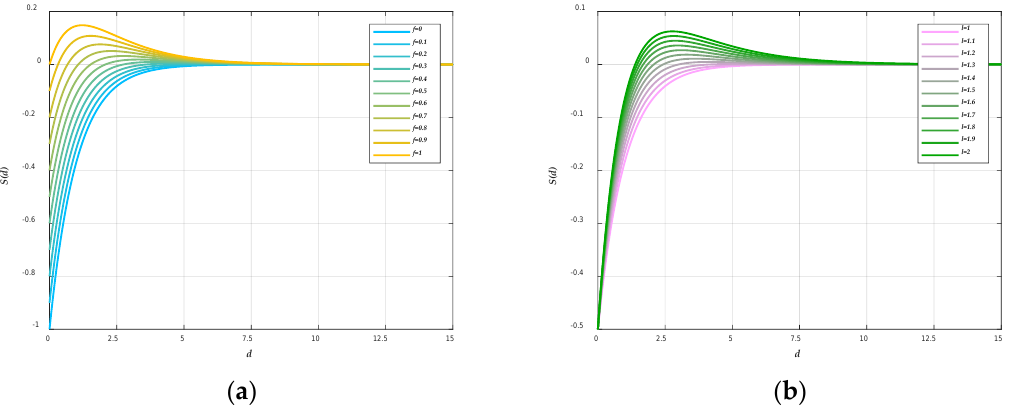
Figure 1. Variation of function s at di ff erent values of f and l . ( a ) l = 1.5 and f in [ 0,1 ] , ( b ) f = 0.5 and l in [ 1,2 ]